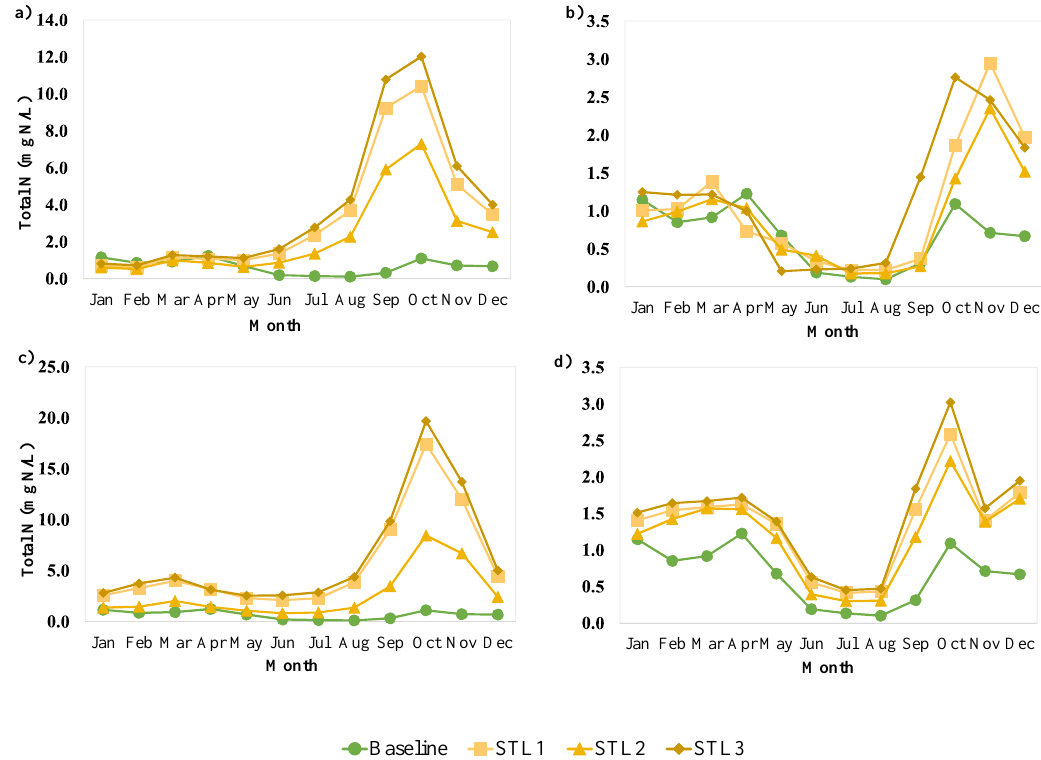
Figure 8. The monthly average of modelled Total N concentration (mg N L − 1 ) for each storyline and baseline period: ( a ) 2030-GFDL; ( b ) 2060-GFDL; ( c ) 2030-IPSL; ( d ) 2060-IPSL. For clarification on the modelled scenarios, please see Figure 2.